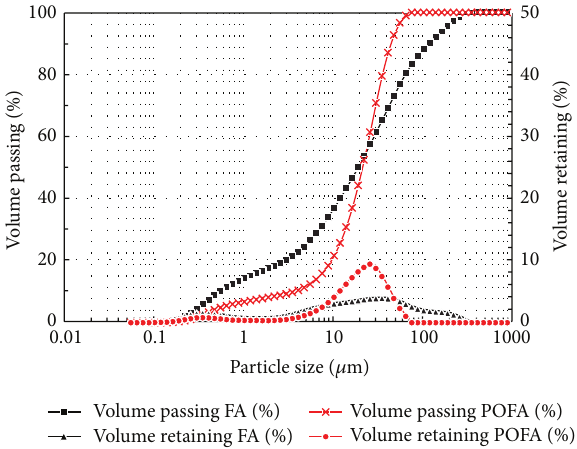
Figure 2: Particle size distribution of POFA and